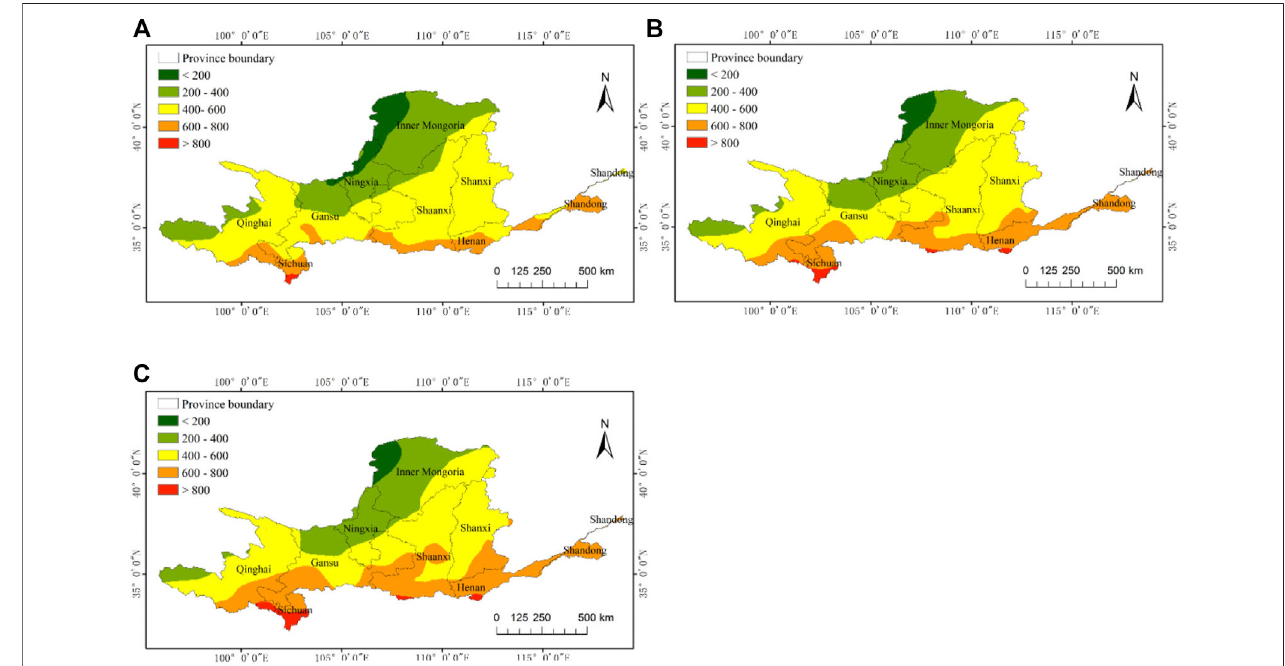
FIGURE 10 | Averaged annual precipitation distribution of the YRB in the historical period of 1986 – 2005. (A) Grid-based BMA ensemble projection of the Yellow River basin in the future period of 2021 – 2050 (B) and 2061 – 2090 (C) .